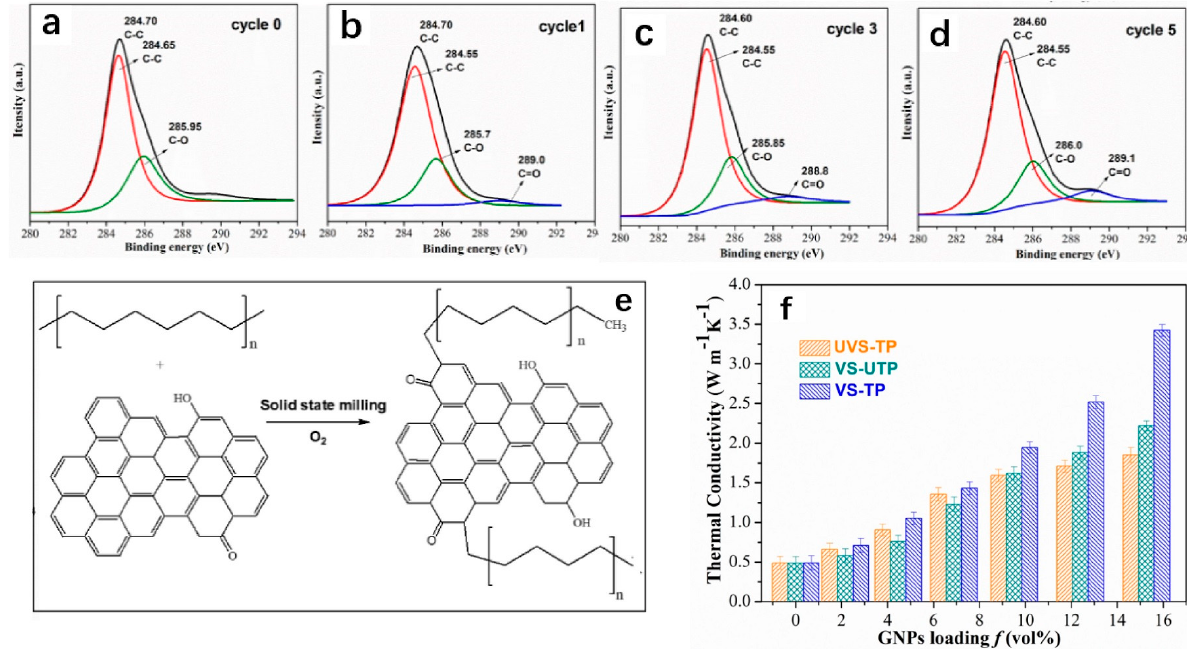
Figure 16. ( a − d ) XPS curves of LLDPE/GNPs after different milling times ( a : 0 milling; b : 1 milling; c : 3 millings; d : 5 millings); ( e ) schematic diagram of mechanochemical reaction during solid − state shear milling; ( f ) thermal conductivity (TC) of FFF 3D prints at different GNP content (TPTC of vertically printed samples after solid − state shear milling (VS − TP), TPTC of vertically printed sam- ples without solid − state shear milling (UVS − TP), and IPTC of vertically printed samples after sol- id − state shear milling (VS − UTP) (reproduced with permission from Reference [66] , Copyright 2020 Elsevier).